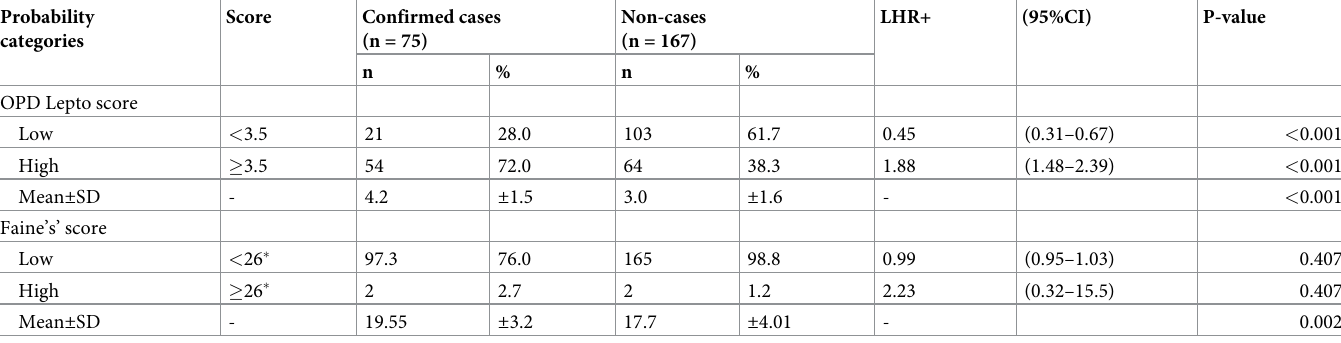
Table 5. Score categorization and likelihood ratio of positive (LHR+) in OPD Lepto Score and Faine’s score. Probability categories